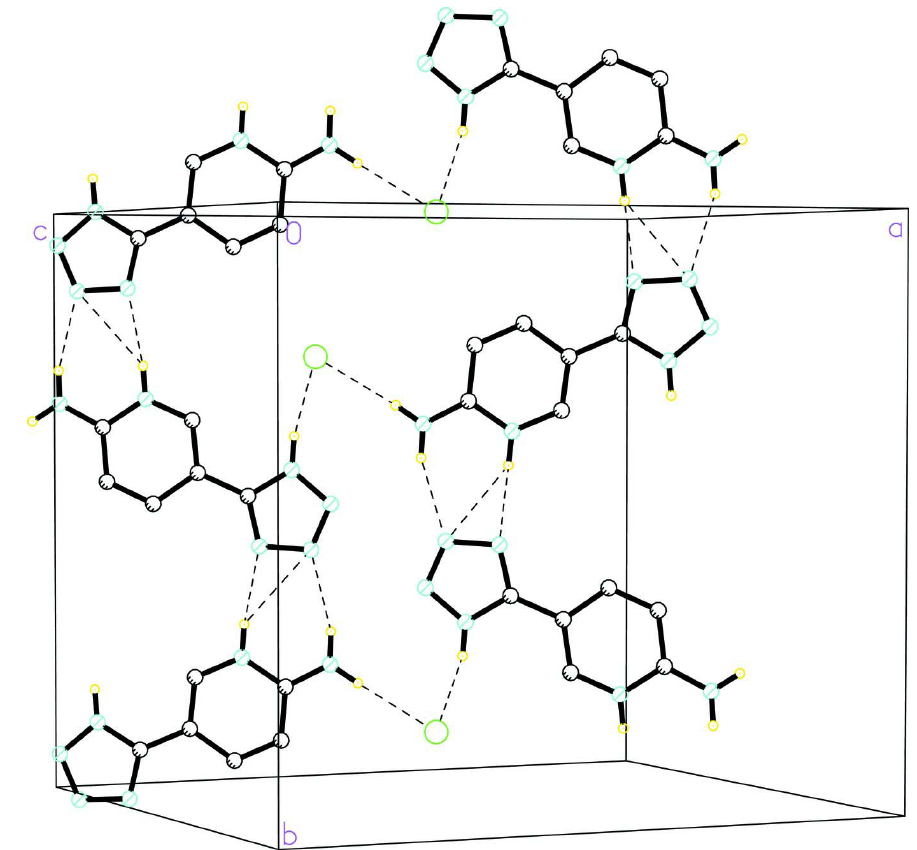
The crystal packing of the title compound viewed along the c axis, showing the two-dimensional hydrogen bonds network. H atoms not involved in hydrogen bonding (dashed lines) have been omitted for